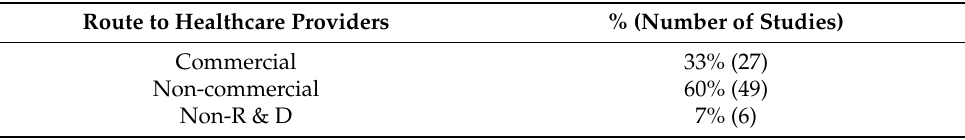
Table 1. Percentage and number of studies GSTFT received in 2019 via commercial and non- commercial